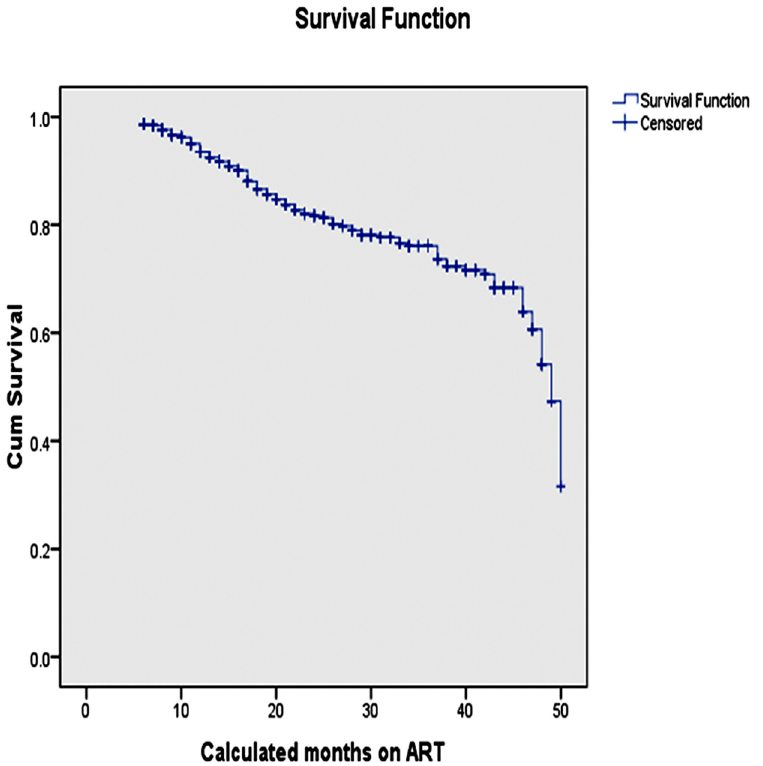
Fig 1. The Kaplan Meier Survival function of ART patients in private health facilities in Addis Ababa, 2009 –